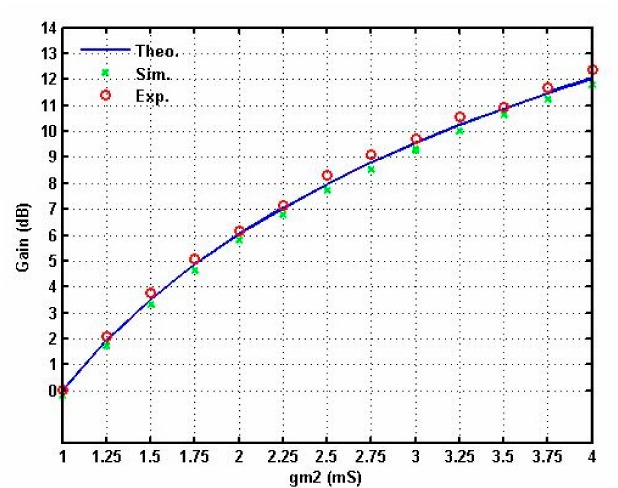
Figure 9. The measured magnitude responses of the V BP3 when R 2 was varied.